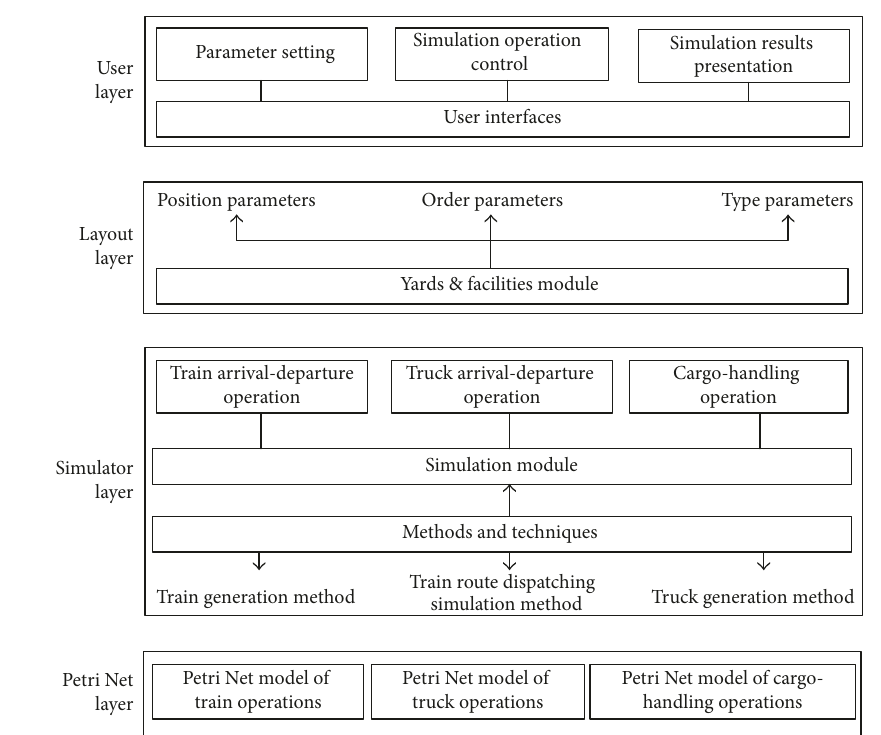
Figure 3: Scheme of truck operations in multiyards railway intermodal terminal.